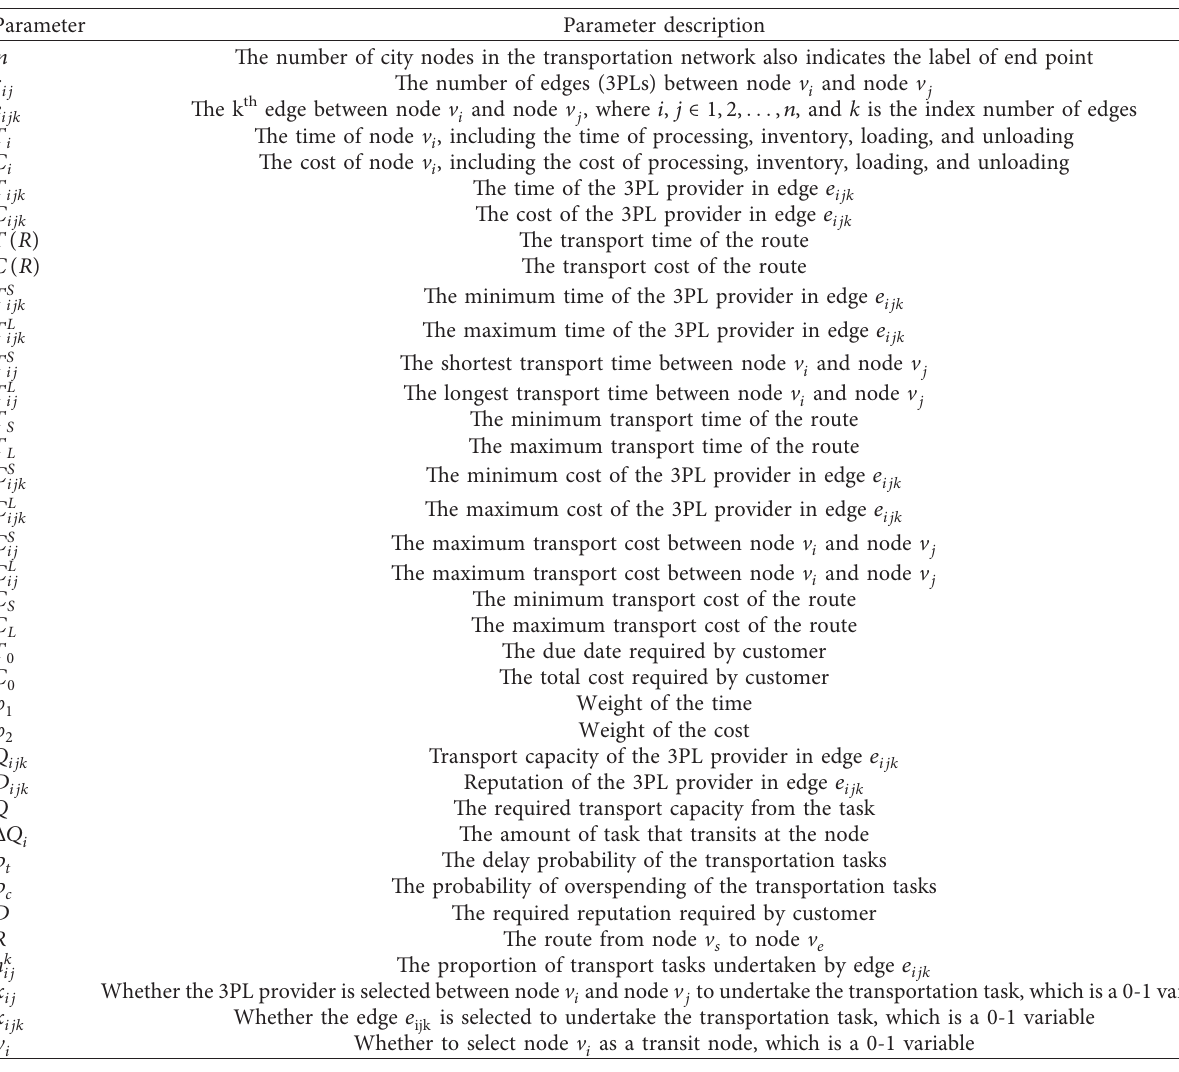
Table 1: Parameter definition of the model.